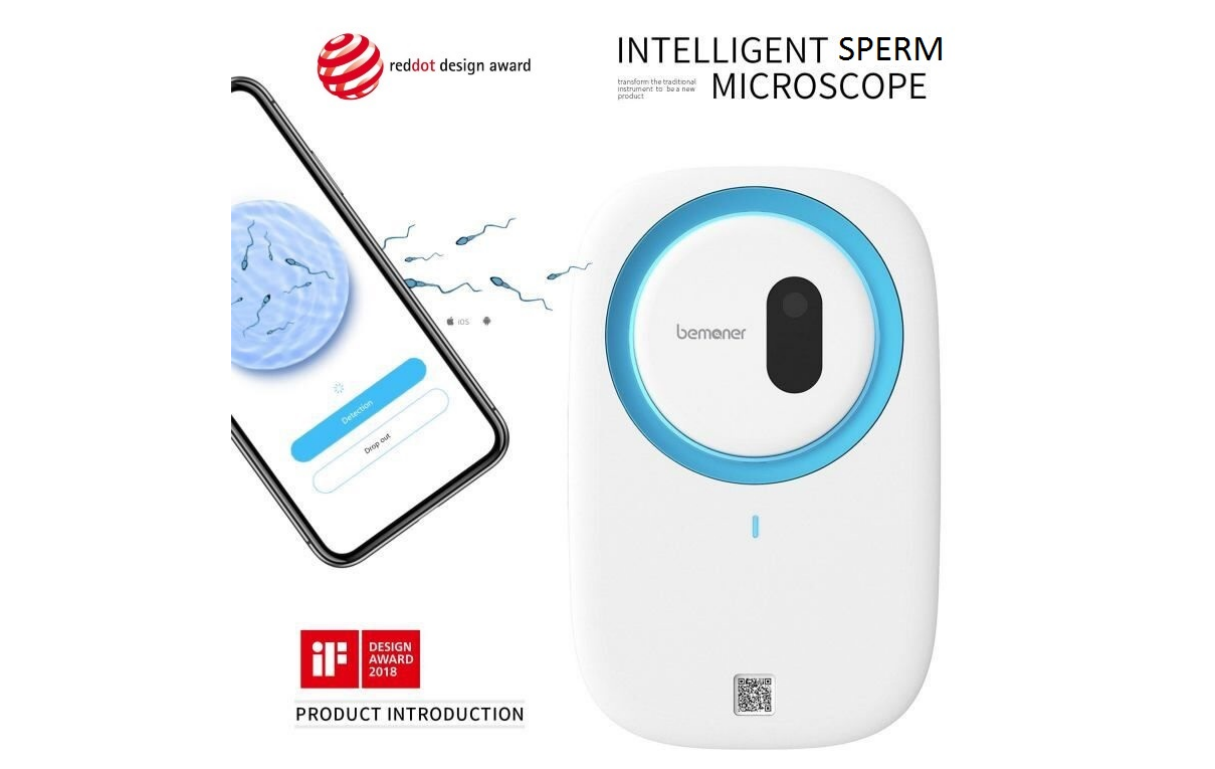
Figure 1. Bemaner smartphone-based home sperm motility test